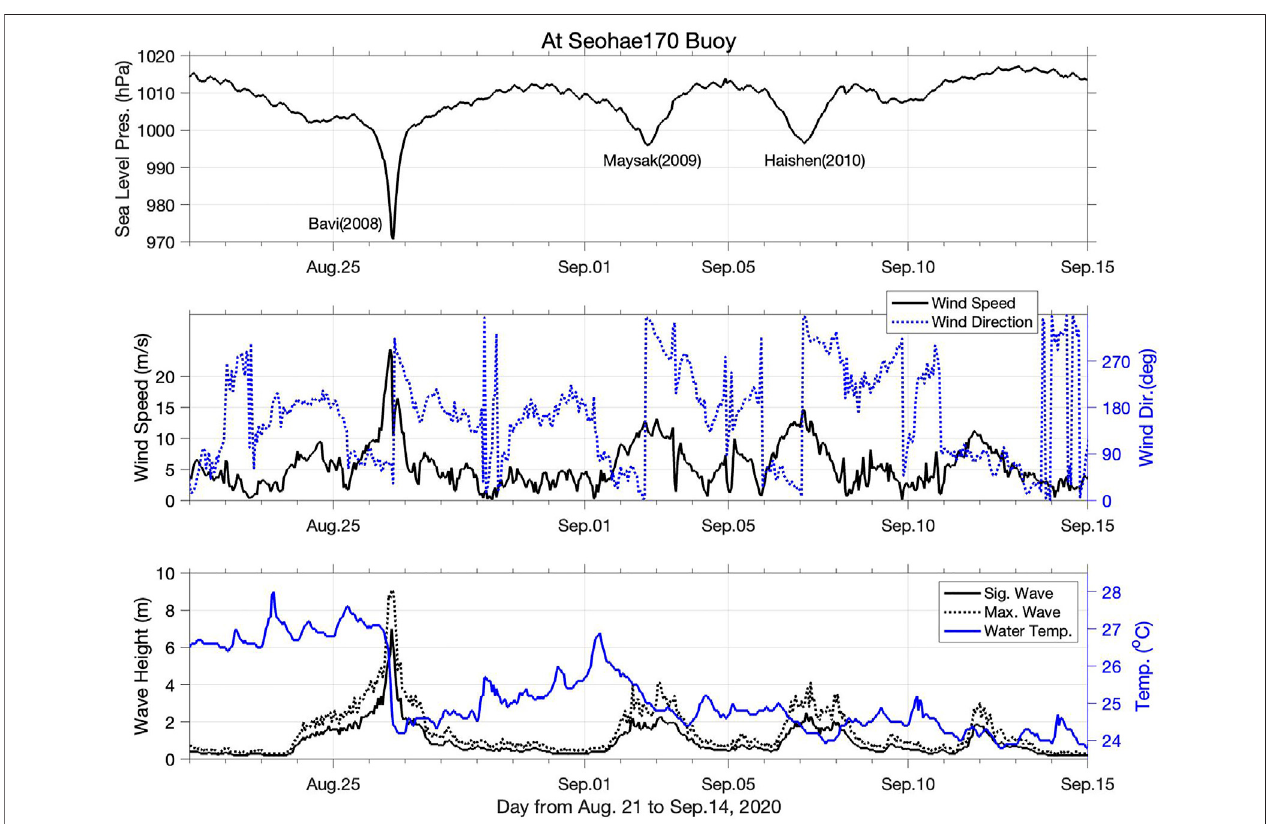
FIGURE 3 | Time series of sea level pressure, wind speeds and direction, and wave height and water temperature obtained by the Seohae170 buoy station from August 21 to September 14, 2020. Time is in UTC units.